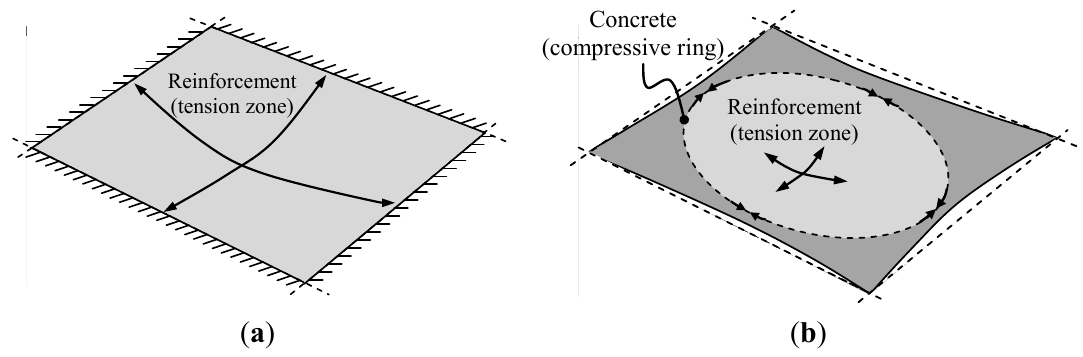
Figure 7. Membrane actions in RC slabs. ( a ) Clamped; ( b )